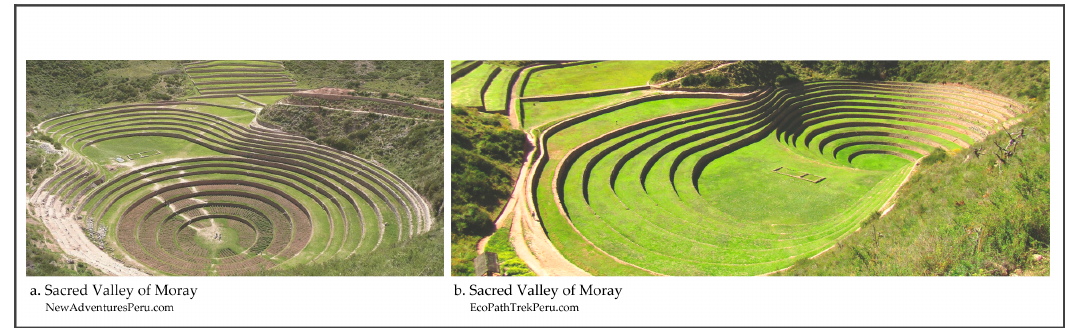
Figure 9. A selected project related to microclimate conditions.